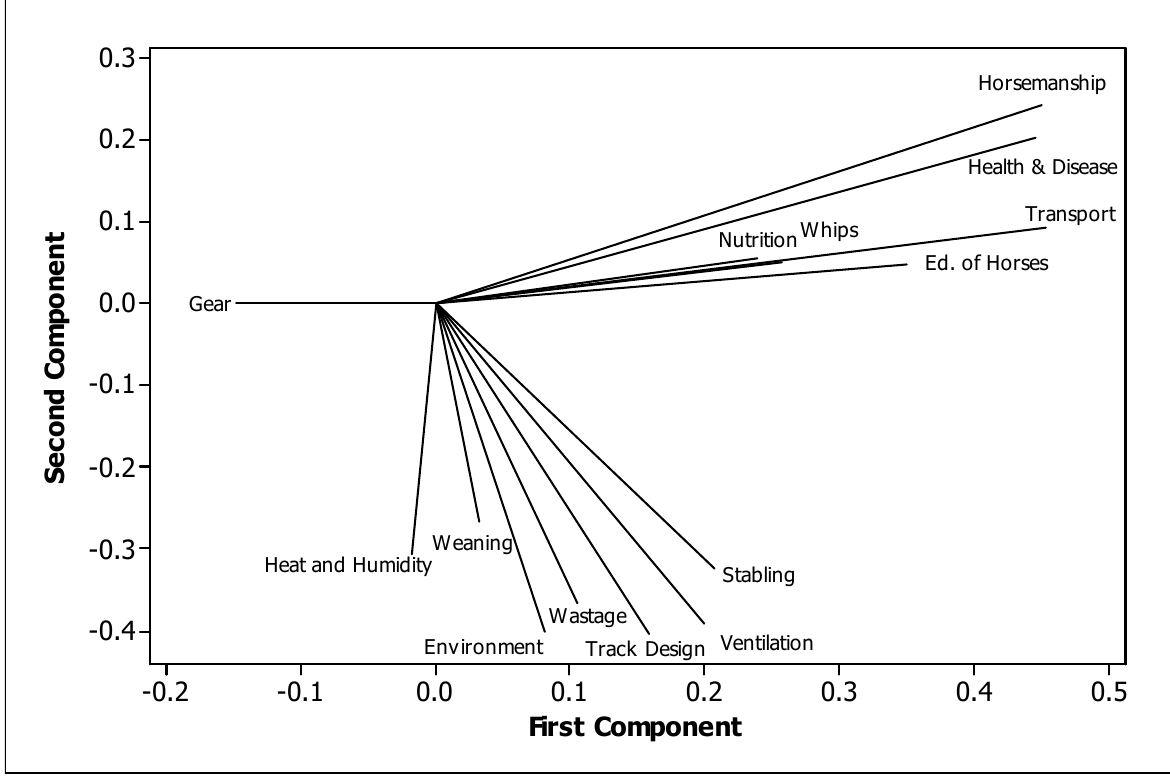
Of the 14 issues tested, 5 had significant or close ‐ to ‐ significant gender differences: were more likely than female respondents (F) to say that their horses raced on other types of tracks (gradual turning turf: M = 17, F = 9; gradual or tight turf or synthetic: M = 10, F = 5; other: M = 16, F = 1) ( Χ 2 = 6.1, p = 0.048). For weaning levels, 2/3 and 4/5 were combined. Compared with men, women were relatively more likely to say that the most common weaning practice was one or two weanlings in a stable (M = 8, F = 8) rather than the removal of one mare at a time from a paddock (M = 7, F = 1) or unknown/other (M = 28, F = 6) ( Χ 2 = 6.4, p = 0.041). After combining nutrition levels 2, 3 and 4, men were more likely than women to say that their horses’ nutritional needs were tailored to their requirements, with access to sup ‐ plements and green forage (M 36, F 9), whereas women were relatively more likely to report a less satisfactory standard of nutrition (M 7, F 6) ( Χ 2 = 3.3, p = 0.068). When levels 2, 3 and 4 were combined in wastage, men were most likely to say they did not know what happened to their horses when they finished racing (M = 20, F = 0), whereas women were relatively more likely to say that the horse was retired to a breeding farm (M = 5, F = 5) or that the horse was used for equestrian sports, given away or slaugh ‐ tered (M = 18, F = 10) ( Χ 2 = 15.9, p < 0.001). In relation to the education of the TBR, women tended to be more likely than men to say that horses received some or no education, whereas men were more likely to say that they received regular education ( Χ 2 = 3.7, p = 0.056). There were no differences between men or women for horsemanship, health and dis ‐ ease, ventilation, stabling, transport, heat and humidity, whips, environment or gear.